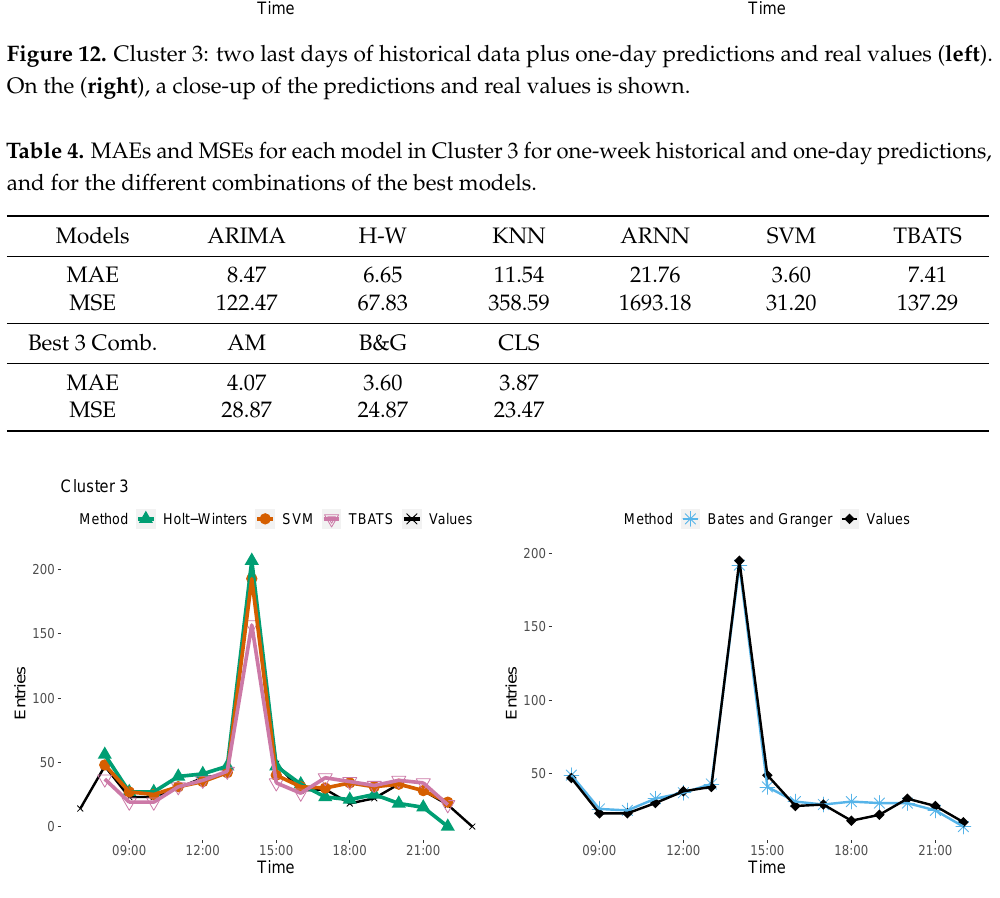
Figure 13. Cluster 3 best 3 models ( left ) and final combined predictions ( right